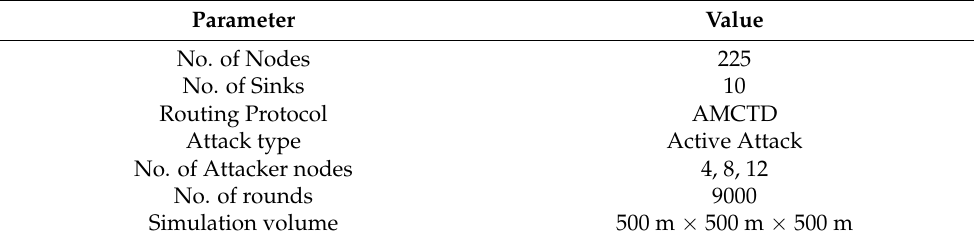
Table 2. Simulation